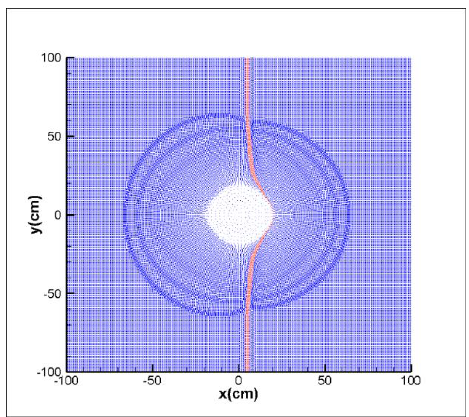
Figure 8. Particles distribution at the end time (example 2).